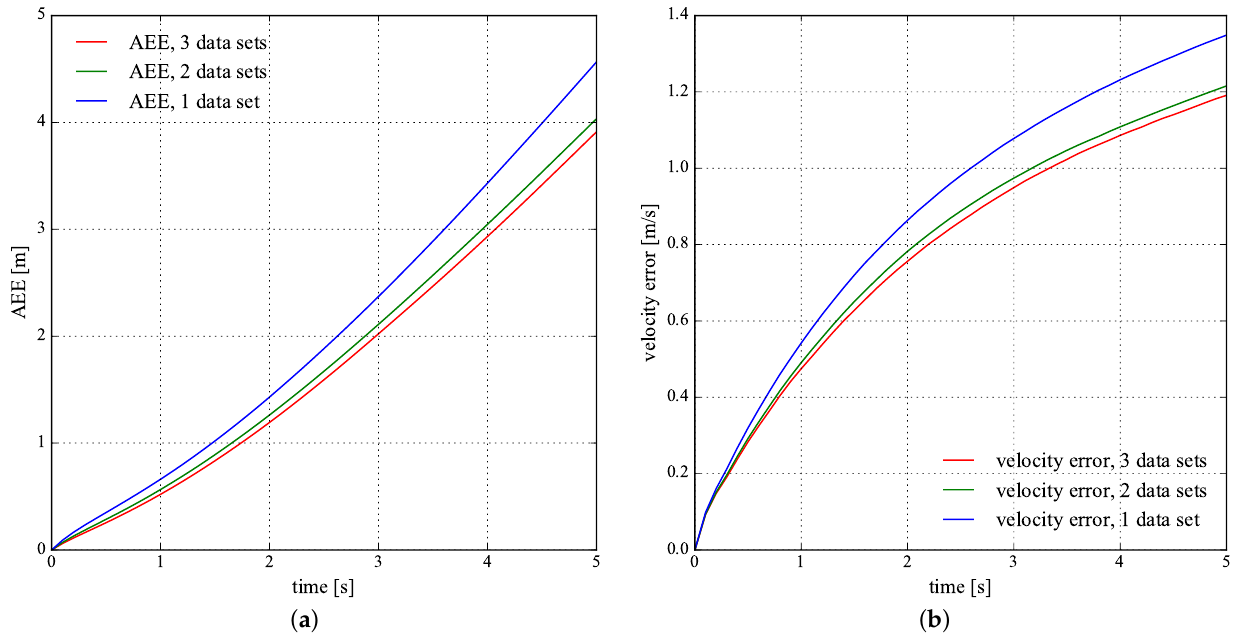
Figure 9. Prediction errors using different data sets. An obvious trend can be found—with the size of used data sets increased, the prediction accuracy of both position and velocity is improved. ( a ) The position prediction error. The red, green and blue curve, respectively, correspond to the position-prediction errors using 3, 2 and 1 data sets. ( b ) The velocity prediction errors. The red, green and blue curve, respectively, correspond to the velocity-prediction errors using 3, 2 and 1 data